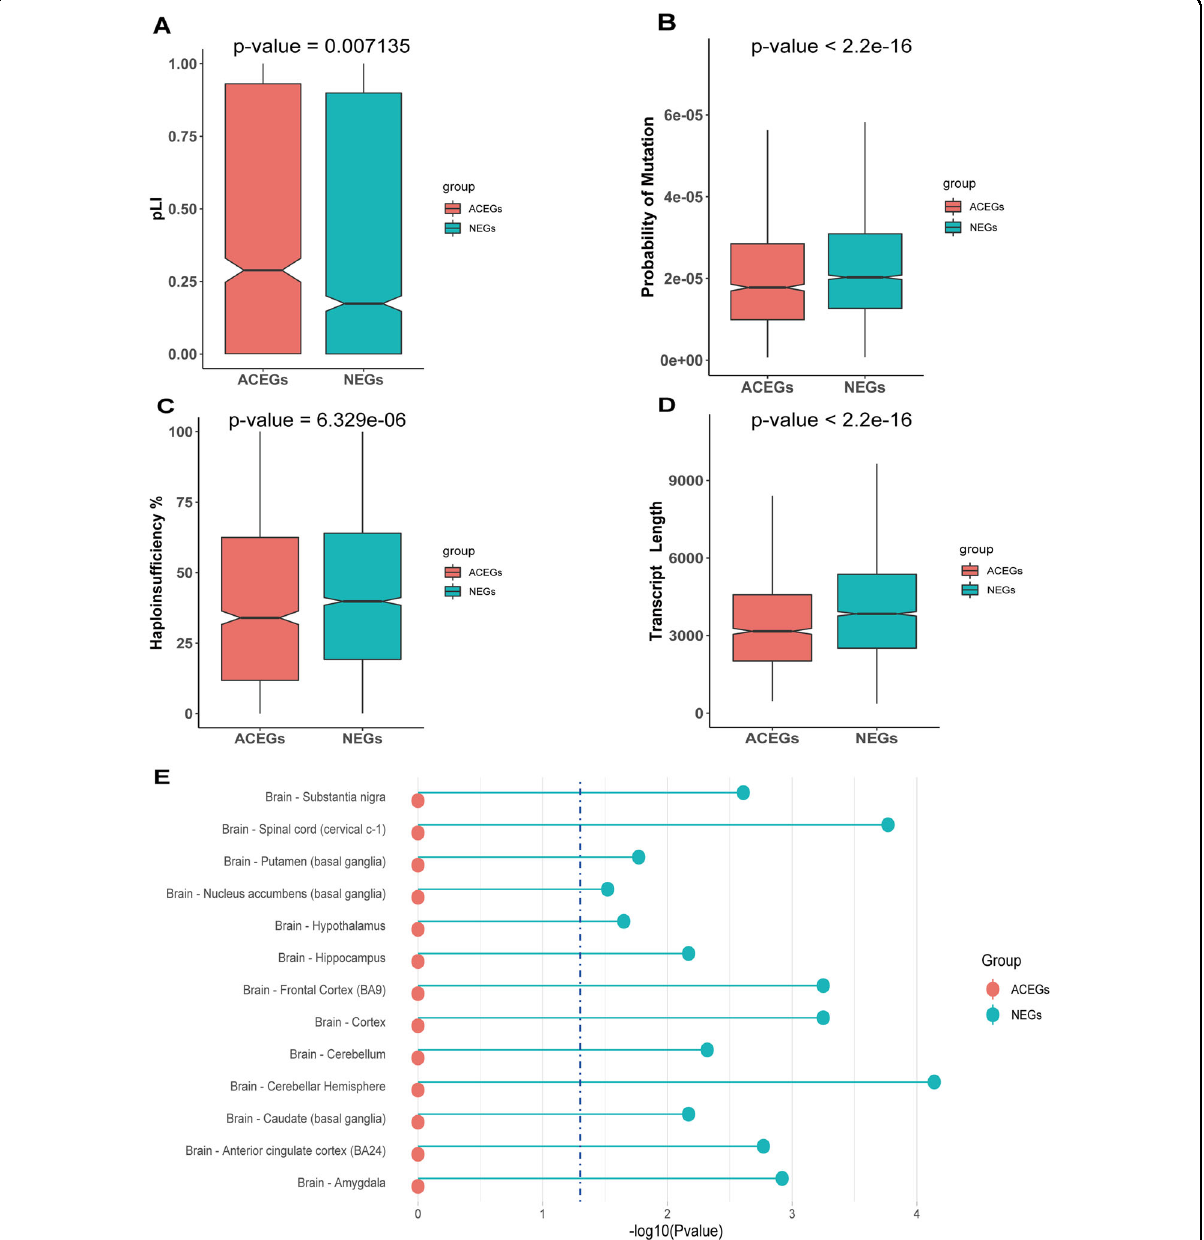
Fig. 5 Comparison of probability of loss-of-function intolerance (pLI), probability of mutation, and haploid insuf fi ciency of Neuronal Essential Genes (NEGs) and Achilles Project-speci fi c essential genes (ACEGs). a pLI of NEGs and ACEGs. b Probability of mutation of NEGs and ACEGs. c Haploid insuf fi ciency rate of NEGs and ACEGs. d Transcript Length of NEGs and ACEGs. e Tissue expression speci fi cities of NEGs and